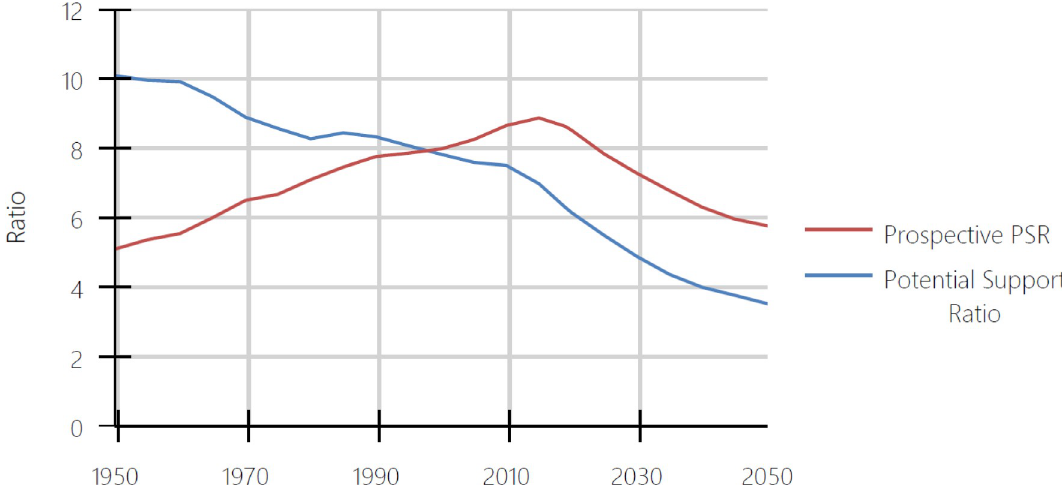
Fig 1. Potential support ratio and prospective potential support ratio, World, 1950–2050. Source: United Nations, Profiles of Ageing 2019 [1].